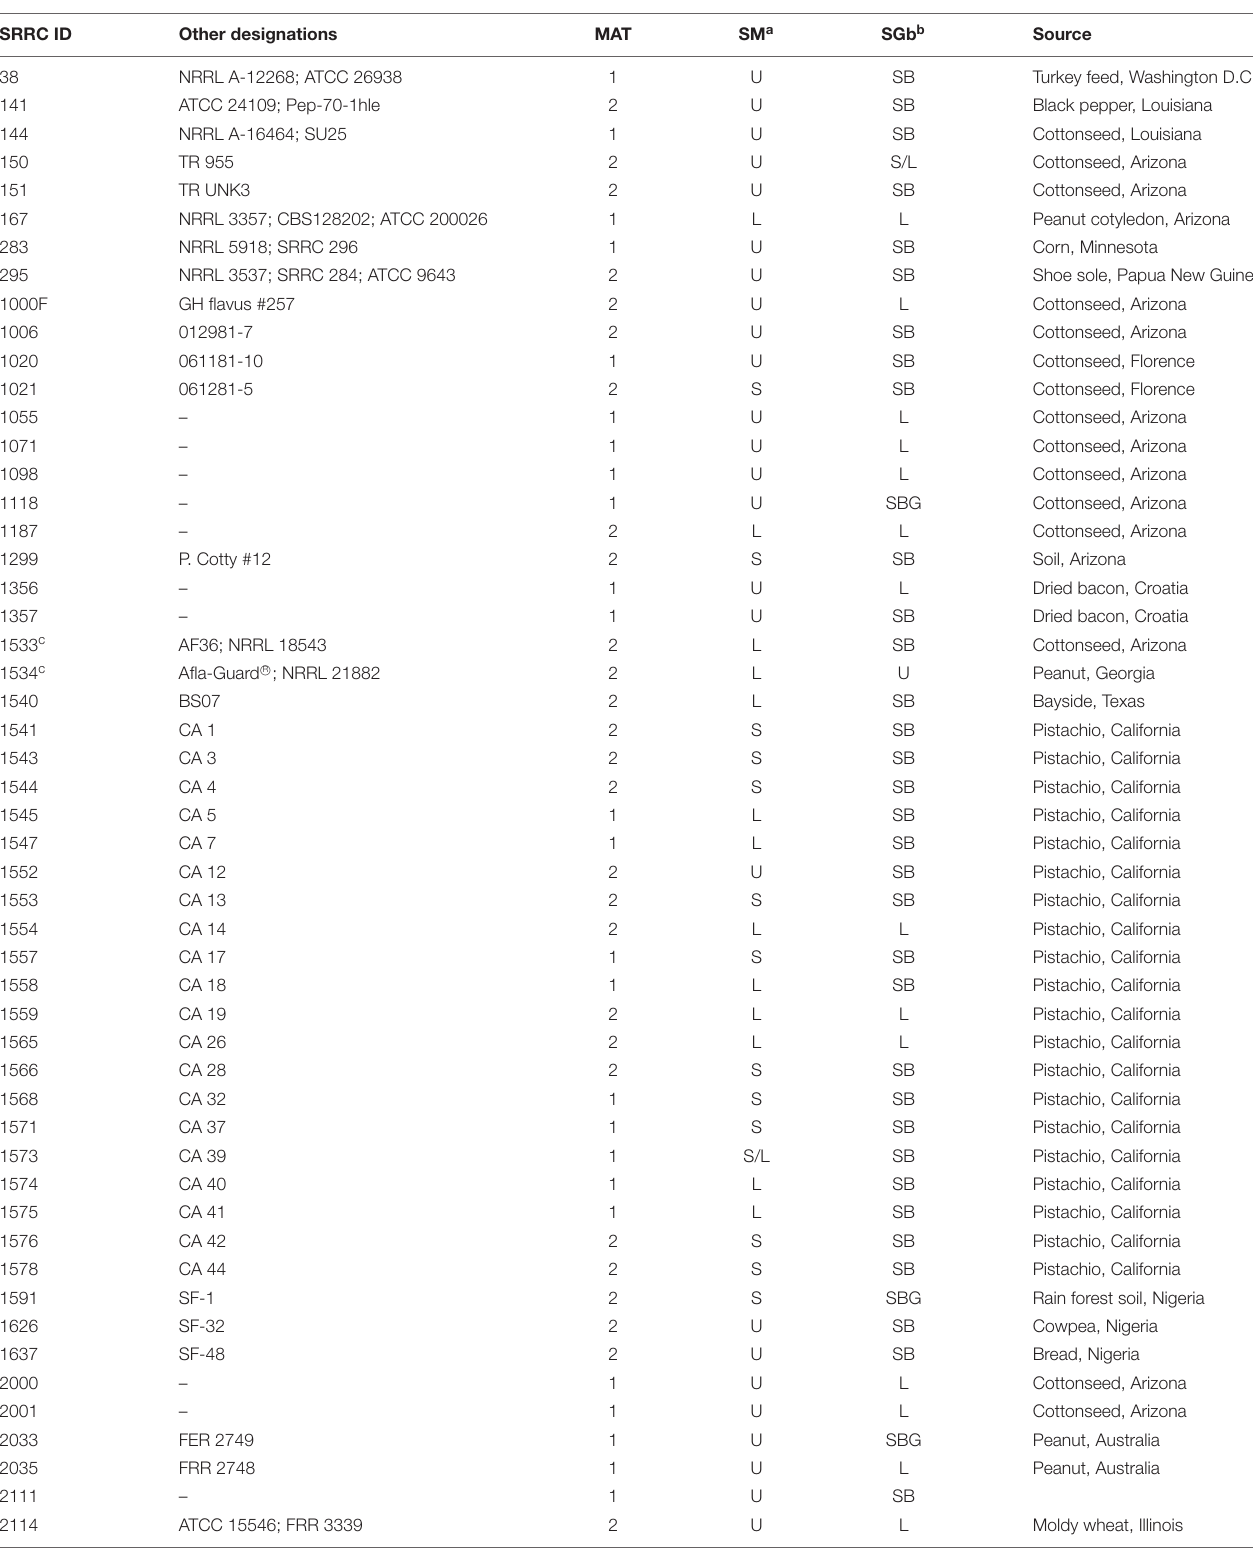
TABLE 1 | List of A. flavus strains used in this study. SRRC